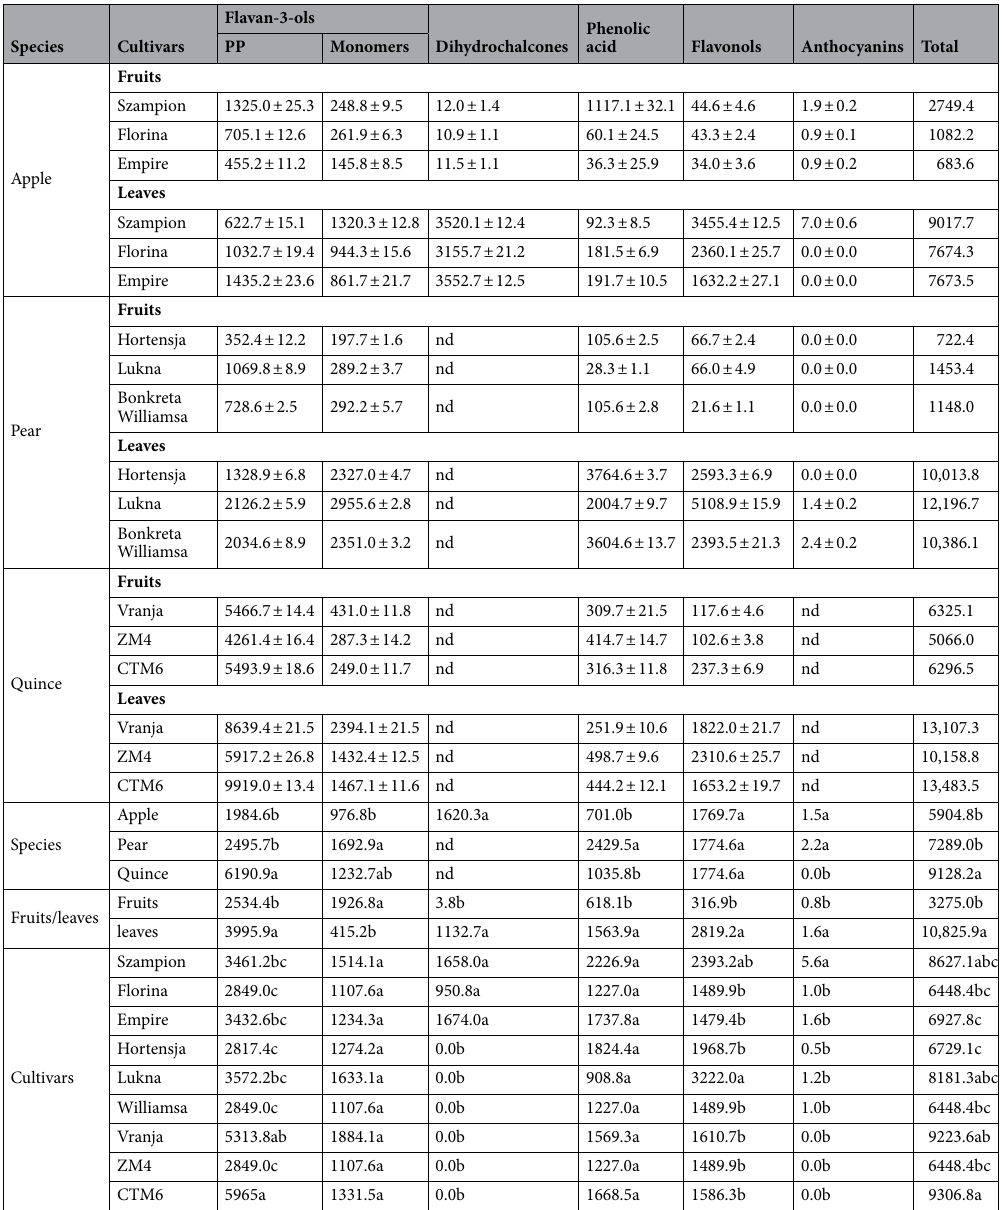
Table 1. Comparison of polyphenols [mg/100 g dw] content in fruits and leaves of some selected species and cultivars of apple, pear, quince fruits and leaves. Mean of 3 replications ± standard deviation followed by the same letter, within the same column were significantly different (p < 0.05) according to Tukey’s least significant differences test. Letters a,b,c,d, represent significance in content (p < 0.05). PP polymeric procyanidins, nd not